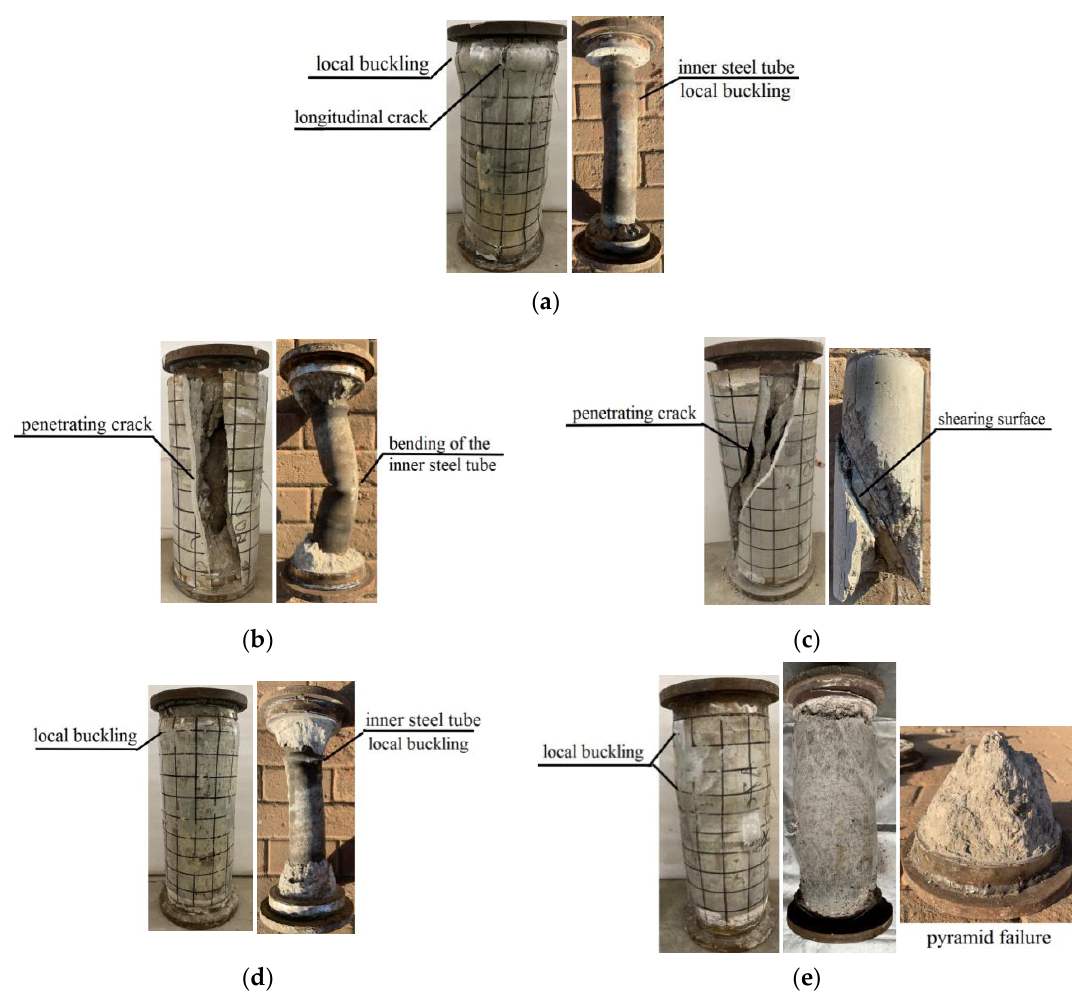
Figure 5. Failure modes. ( a ) CFAT-CHS failure, ( b ) ATCC-CHS failure mode I, ( c ) ATCC failure mode I, ( d ) ATCC-CHS failure mode II, and ( e ) ATCC failure mode II. Both the STCC-CHS-1 and STCC-1 specimens had ductile failures with multiple localized areas of circumferential buckling. The thin-walled ATCCs had poor confinement, leading to brittle failure. Moreover, since the column-end constraint was not considered in the specimen design, there were uneven loads on the column, causing column-end failure. In addition, although the axial shortening of the different materials was similar, and although the thick-walled ATCC specimens showed ductile failure similar to that of the STCCs, the buckling deformation of the aluminum tubes was smoother than that of the carbon steel tubes. This was mainly because of their greater plasticity and strain hardening of the carbon steel. When there was steel tube buckling, the tube imposed effective lateral constraint on the internal concrete core, which allowed the load to increase continuously before any new local buckling occurred. 3.2. Comparison of Axial Loads The axial load ( N ) and displacement ( Δ ) data are summarized in Figure 6. The N - Δ curves of all three types of specimens show ductile characteristics. At that point, there was already plastic deformation. Table 1 specifies all the ultimate loads. Figure 7 displays the axial compression stiffnesses K and tangent stiffnesses calculated at 0.4 N u [39]. The influence of the diameter – thickness ratio on the load – displacement curve of the ATCC-CHS specimens is shown in Figure 6a,e. Within the range tested in this study ( D o / t o = 14 – 28), Nu increased linearly with decreases in the diameter – thickness ratio of the outer tube. When the ratio decreased from 28 to 14, the ultimate load increased by 22.6%, and the axial compression stiffness increased by 6.5%. Since the inner steel tube was directly subjected to longitudinal loading, when the diameter – thickness ratio of the inner steel tube decreased from 27 to 12, the ultimate strength of the specimen increased by 41.0%. Therefore, the diameter – thickness ratio of the inner steel tube had more influence on the performance of the column. In addition, for an ATCC specimen the ultimate load increased by 45.6% due to the changing diameter – thickness ratio, indicating that the constraint of the outer aluminum tube plays a more significant role in the compressive strength of the concrete.